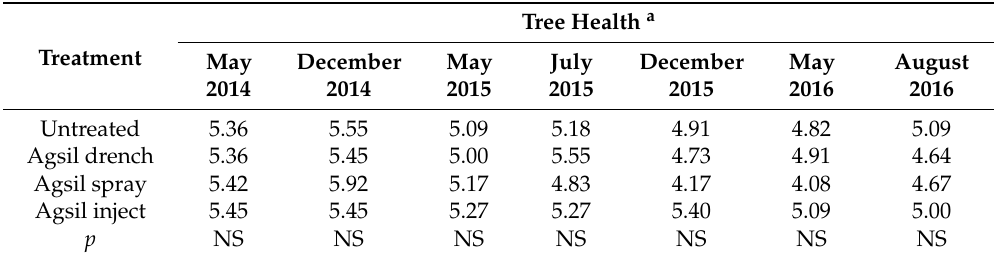
Table 3. Tree health data for 2014–2016 from Agsil amendment trial—Site 3, Beechmont.